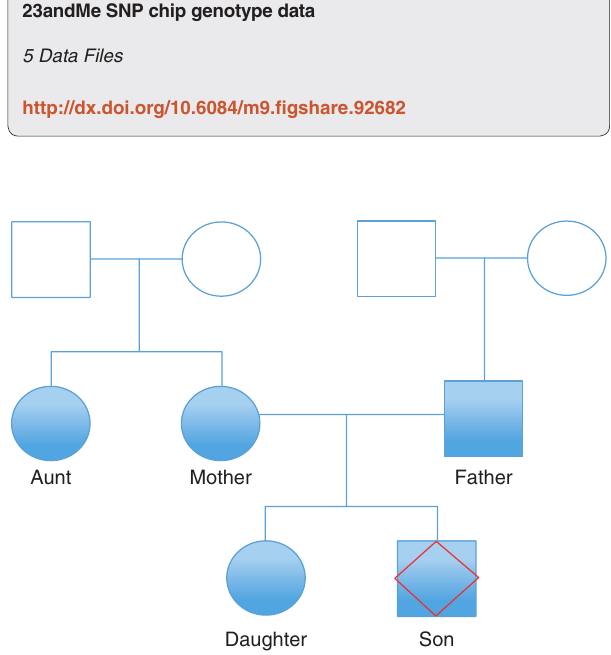
Figure 1. Family tree analyzed using DTC genotyping services. Squares and circles denote male and female respectively. Filled shapes represent those for which genome data is available. ‘Son’, the individual whose exome was sequenced, is denoted with a red diamond. Other family members include Father, Mother, Daughter and Aunt, who is Mother’s